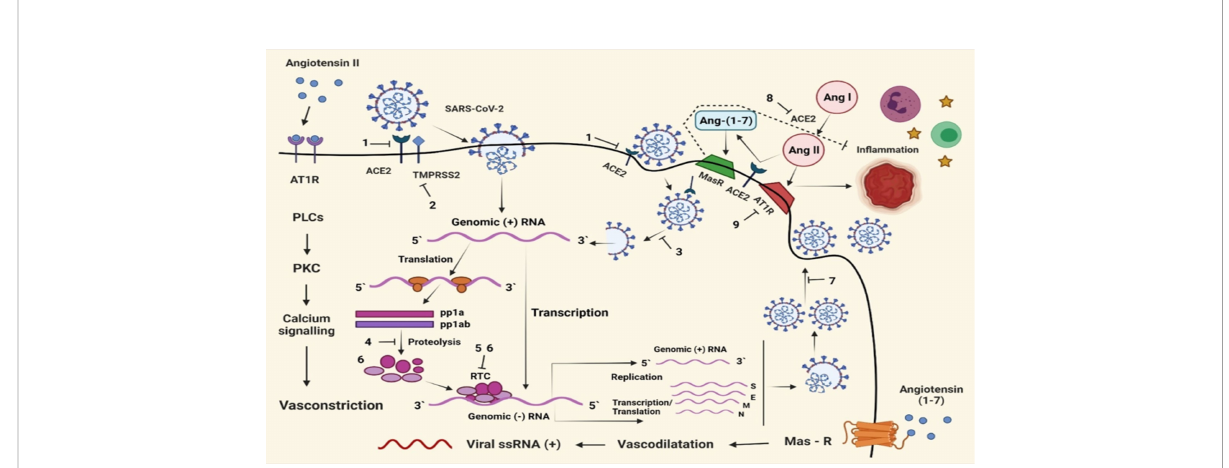
FIGURE 1 Potential therapeutic strategies are concerned with four aspects: inhibition of virus entry, virus replication, the release of virus offspring, and modifying RAAS. Viral S-protein bonding to ACE2 1. Activity of TMPRSS; 2. Endocytic pathway-Cleavage of S-protein by cathepsin L; 3. Internalization of virus prevented; 4. The replicative activity of RTC inhibited; 5. Increase intracellular Zn 2+ concentration; 6.Inhibition of viroporin mediated viral budding; 7. Blockage of ACE2 resulting in excessive in fl ammation; 8. AT1R; 9. 3CL Pro ,3 -chymotrypsin like protease; ACE2; AT1R; S, spike; N, nucleocapsid; E, envelop; M, membrane; PL Pro , pepsin like protease; PP, polyprotein; RAAS; RTC, replication- transcription complex; TMPRSS2, transmembrane protease serine 2 (Prasansuklab et al.,